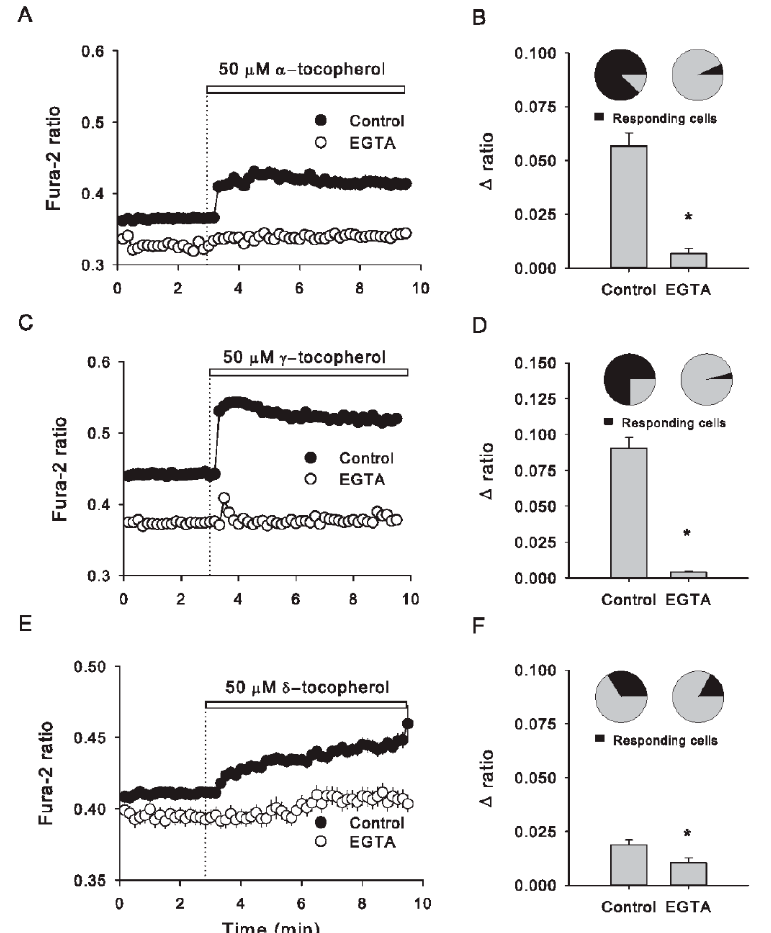
Figure 2. Removal of extracellular Ca 2+ abolishes intracellular Ca 2+ increases induced by all tocopherol isomers in Caco-2 cells. ( A ) Time course of Fura-2 fluorescence ratio in Caco-2 cells in the presence of an extracellular buffer without Ca 2+ and supplemented with 5 mM EGTA (EGTA, open circles) or in a normal condition with Ca 2+ (control, filled circles); 50 μ M α -tocopherol was added at the time indicated by the dotted line and the white bar on the plot. Data correspond to the average ± SE of 41 control cells from three independent experiments and 146 EGTA-treated cells from six independent experiments. As described in ( A ), the plot in ( C ) shows the effect induced by 50 μ M γ -tocopherol. Data correspond to the average ± SE of 44 control cells from three independent experiments and 109 EGTA-treated cells from four independent experiments. ( E ) The effect of δ -tocopherol is shown. Data correspond to the average ± SE of 63 control cells from four independent experiments and 110 EGTA-treated cells from seven independent experiments. In ( B , D , F ), cytosolic calcium increases were quantified as the subtraction between average values of Fura-2 ratio obtained 3 min before and after those of α -, γ and δ -tocopherol isomers addition in control and EGTA-treated cells, respectively. Above each bar, a pie chart represents the proportion of responding cells for each experimental condition. The asterisks mean statistical differences obtained by nonpaired t-Student test.